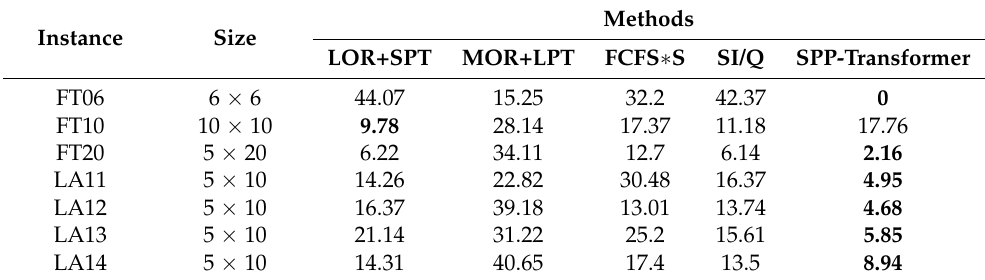
Table A4. The comparison between composite dispatching rules and SPP-Transformer on RPD